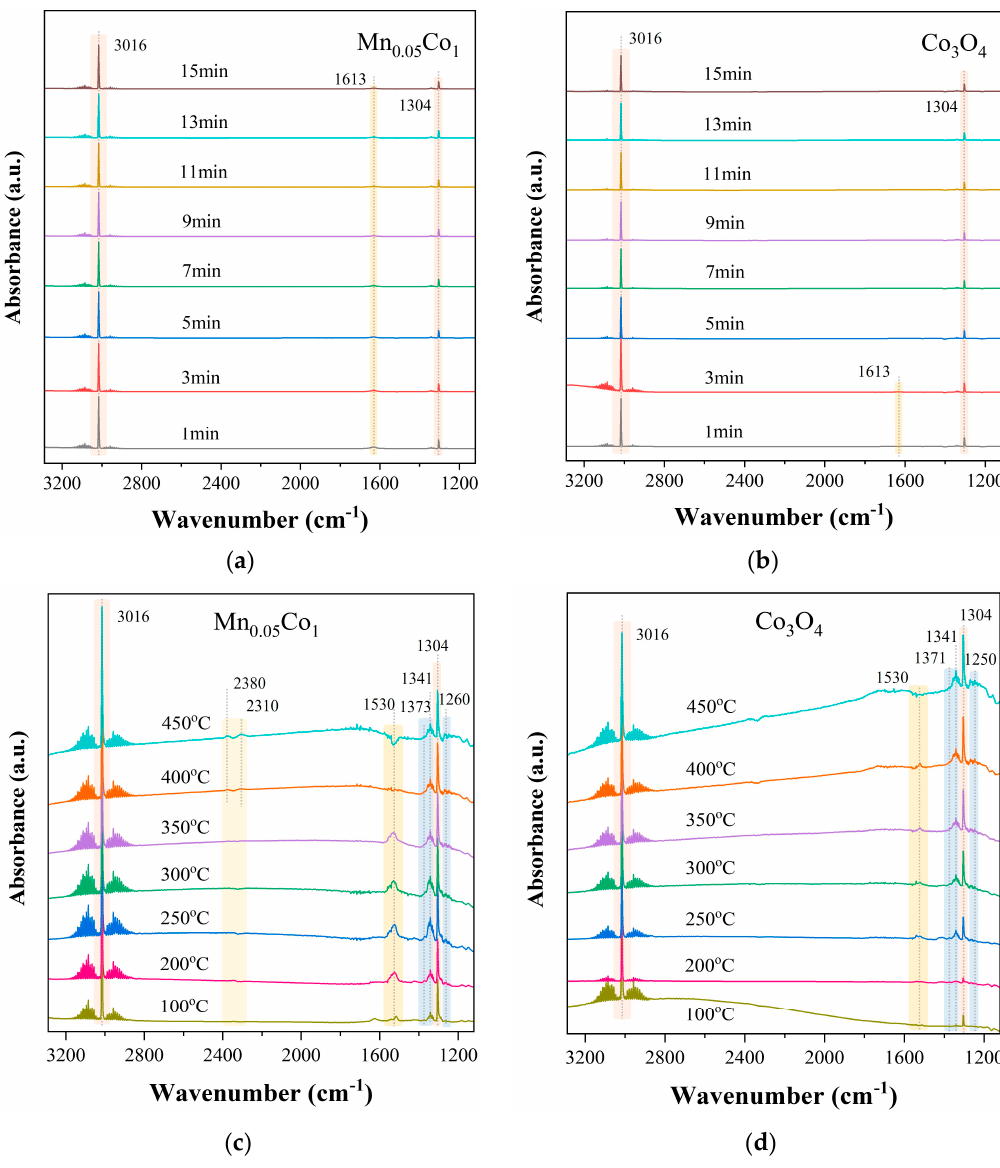
Figure 7. In situ DRIFTS spectra of CH 4 adsorption over the ( a ) Mn 0.05 Co 1 and ( b ) Co 3 O 4 catalysts as a function of time at 30 °C, and the in situ DRIFTS spectra with the temperature increased after CH 4 + O 2 adsorption over the ( c ) Mn 0.05 Co 1 and ( d ) Co 3 O 4 catalysts.